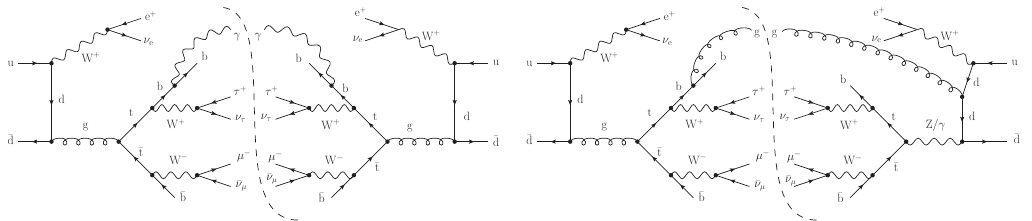
( α 2 α 7 ) real corrections to off-shell ttW production in the three- Figure 4: Sample s O charged-lepton decay channel: EW corrections to LO to the LO interference